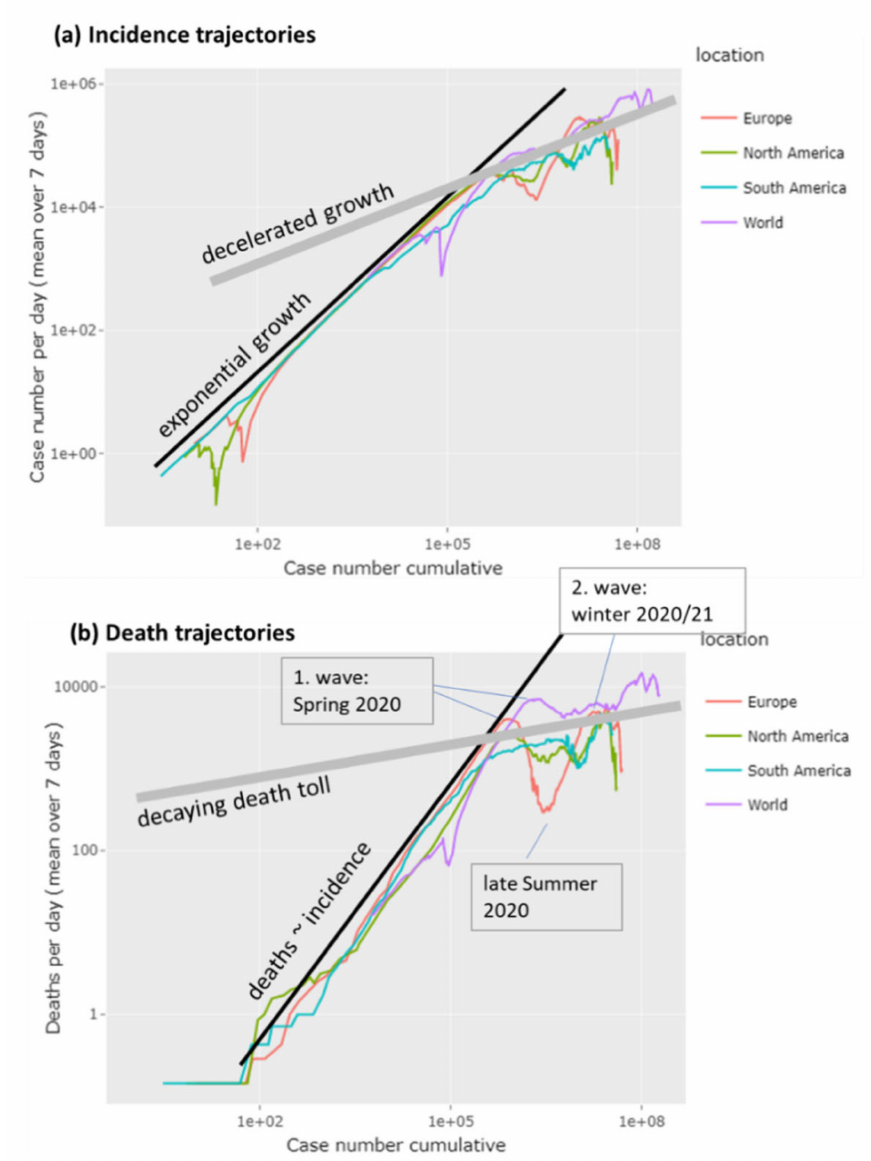
Figure A3. Trajectories of the pandemic in log-log scale worldwide and for selected regions (Europe, North and South America). ( a ) The plot of the number of new cases (per day) as a function of cumulative cases visualizes the exponential character of the pandemic as a line (see [28] for the detailed description of the method). The exponential growth decelerates since summer 2020 owing to NPIs, medical services and vaccination. ( b ) The number of deaths followed the incidence at the beginning of the pandemic (black line) until summer 2020. Then it markedly deviates towards smaller values, but it still grows in absolute numbers (the thick grey line serves as guide for the